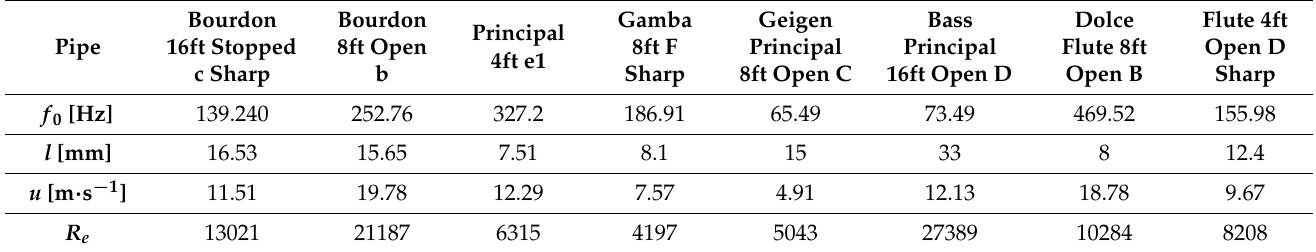
Table 5. Values of Reynolds number R e and flow velocity u for analyzed flue pipes at S r =